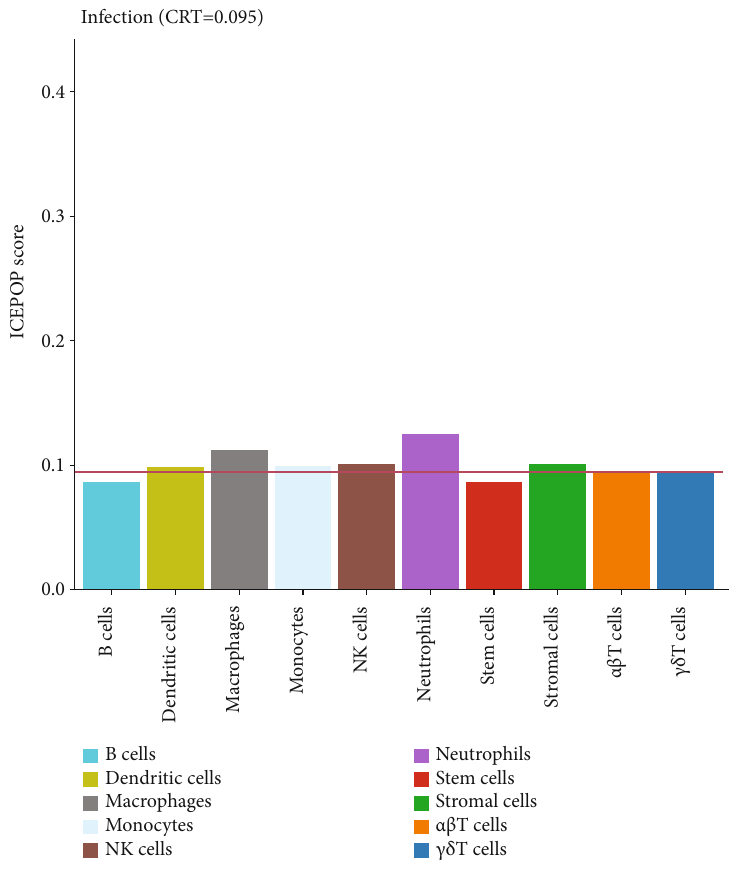
Figure 5: Immune cell population of di ff erential gene expression. The height of the histogram (ICEPOP Score) represents the extent of cell response. Cell type response threshold (CR, red line) is a threshold to determine whether a cell type is responding or